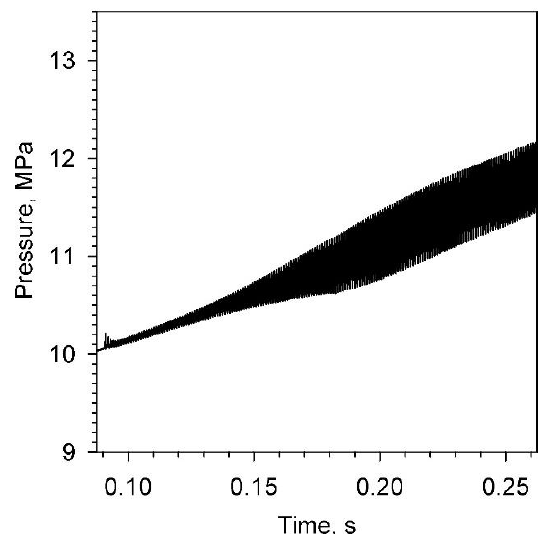
Figure 5. Predicted head-end pressure-time profile, reference motor ( K Δ H = 150,000 J/kg, α s